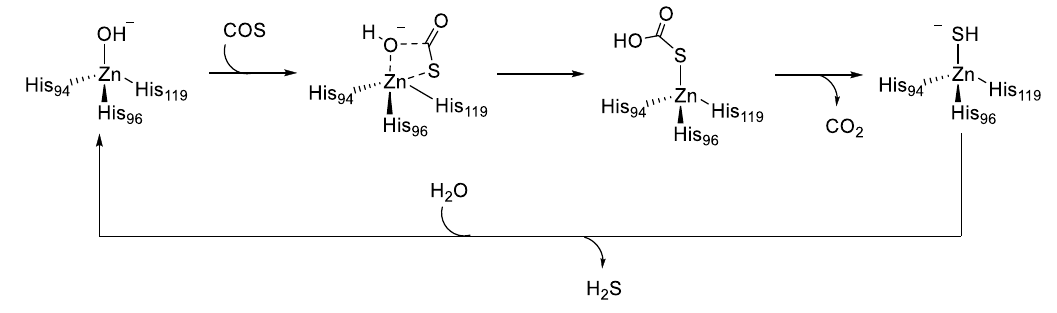
Figure 4. Catalytic hydration mechanism of carbonyl sulfide (COS).